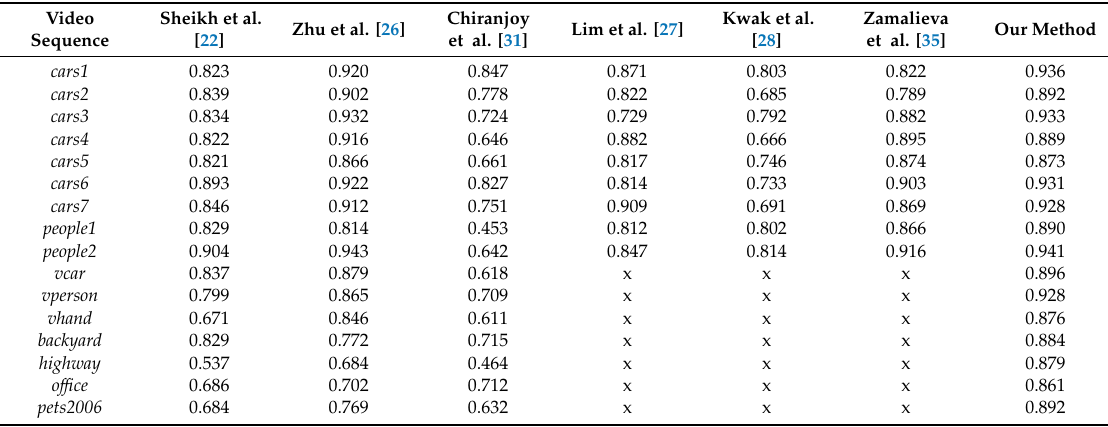
Table 2. Quantitative evaluation of pixel level